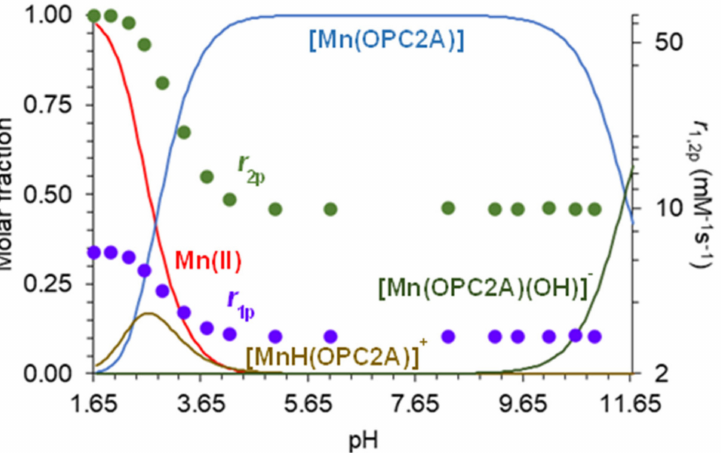
Figure 2. Species distribution curves calculated for the [Mn( 3,9-OPC2A )], along with the pH depen- dence of its relaxivity ( r 1p : • and r 2p : • ) (T = 25 ◦ C, I = 0.15 M NaCl, 1.41